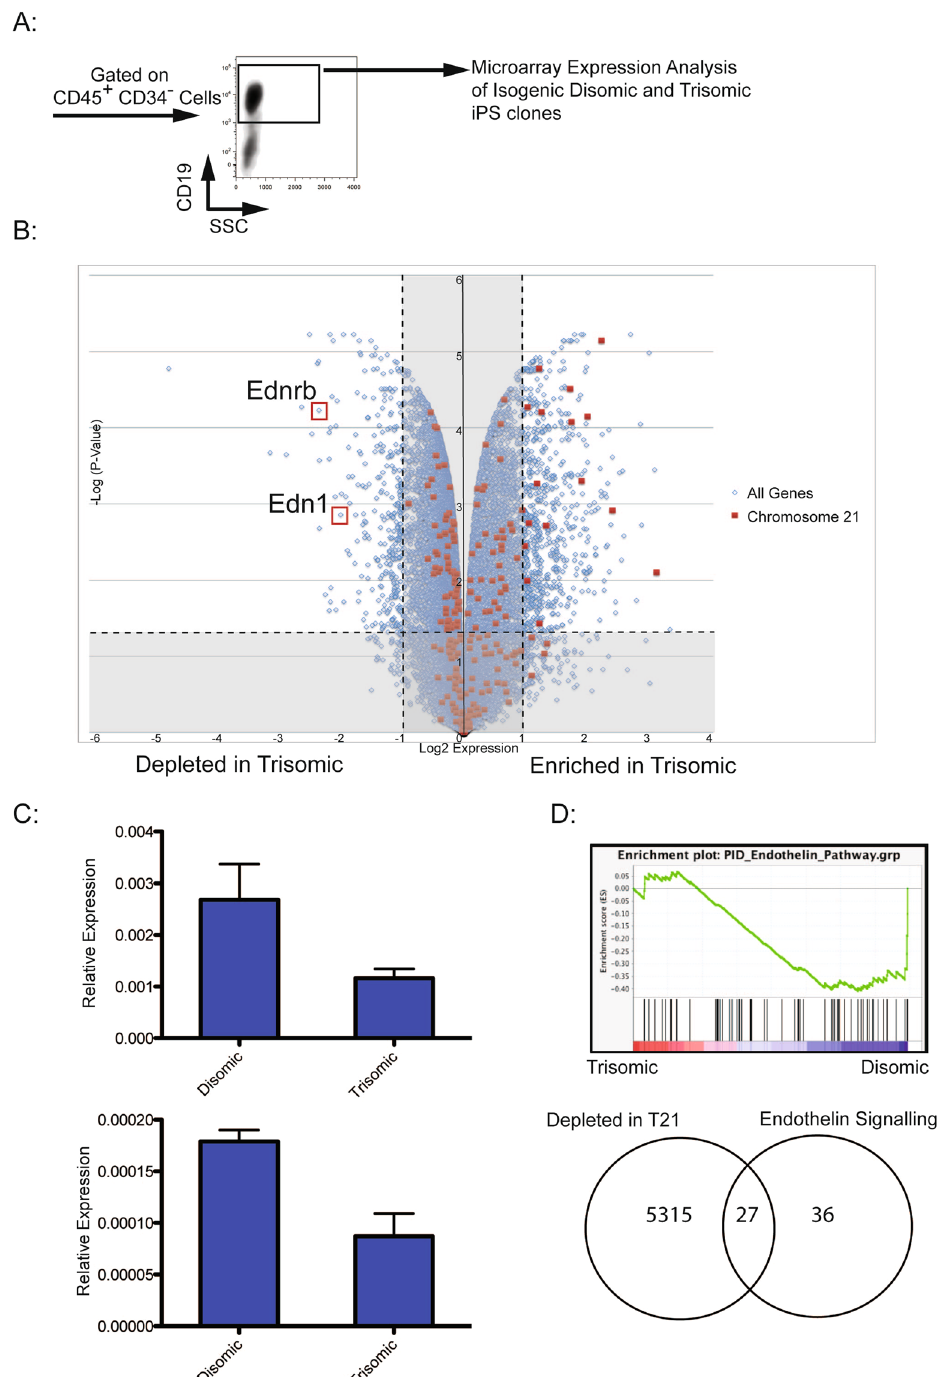
Figure 3. Global Gene Expression Analysis of Differentiated B Cells. ( A ) Gating profile of CD45 + CD34 − CD19 + cells isolated for expression analysis. ( B ) Volcano plot showing distribution of expressed genes in differentiated trisomic cells relative to disomic cells. Log 2 (fold-change) is displayed on the X-axis, and Log (Adjusted P-Value) is along the Y-axis. Red squares represent genes on chromosome 21, and blue squares represent all other genes. ( C ) qPCR validation of EDNRB and EDN1 expression in differentiated disomic and trisomic cells (N = 3 for each). Both genes are downregulated in trisomic cells, validating microarray results. ( D ) Gene Set Enrichment Analysis with a Endothelin Pathway gene set showing enrichment in differentiated disomic cells. A Venn diagram was constructed using the same Endothelin Pathway gene set, and genes depleted in trisomic clones by Log(fold change) < 0.2, to indicate that 43% of the genes in the set are also depleted in differentiated trisomic clones (P-value <